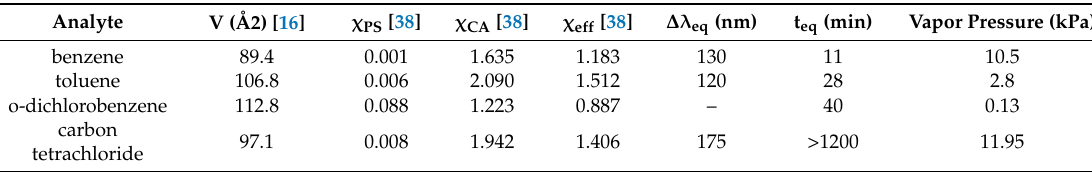
Table 2. Analytes van der Waals Volumes (V); Flory–Huggins parameter for PS ( χ PS ), CA ( χ CA ), and for the entire DBR ( χ eff ); photonic band-gap (PBG) spectral shift at the equilibrium ( ∆ λ eq ); time required to reach saturation (t eq ); and analyte vapor